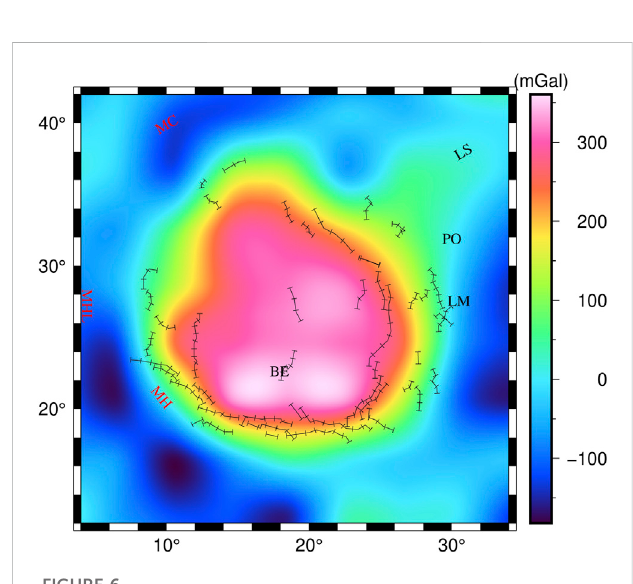
FIGURE 6 The 4th-order wavelet approximation A4 of the Bouguer gravity